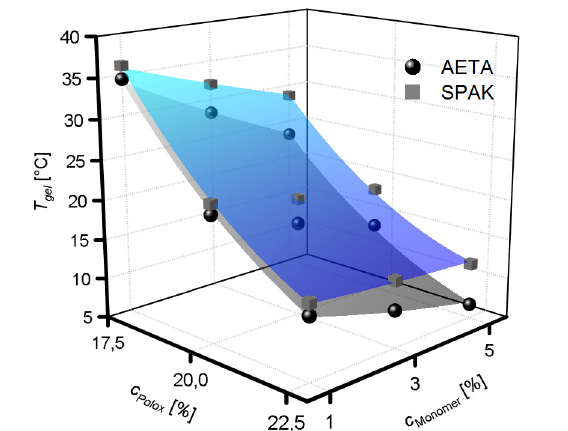
Figure 5. Gel transition temperatures ( T gel ) of ink formulations with varying concentrations ( c Monomer ) of positively and negatively charged monomers. The surface fits to the data points are to guide the eye